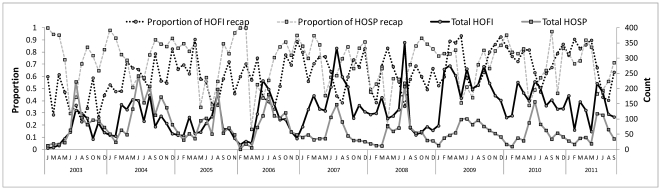
Total numbers of House Finches and House Sparrows collected per month and the proportion banded or recaptured (recap).